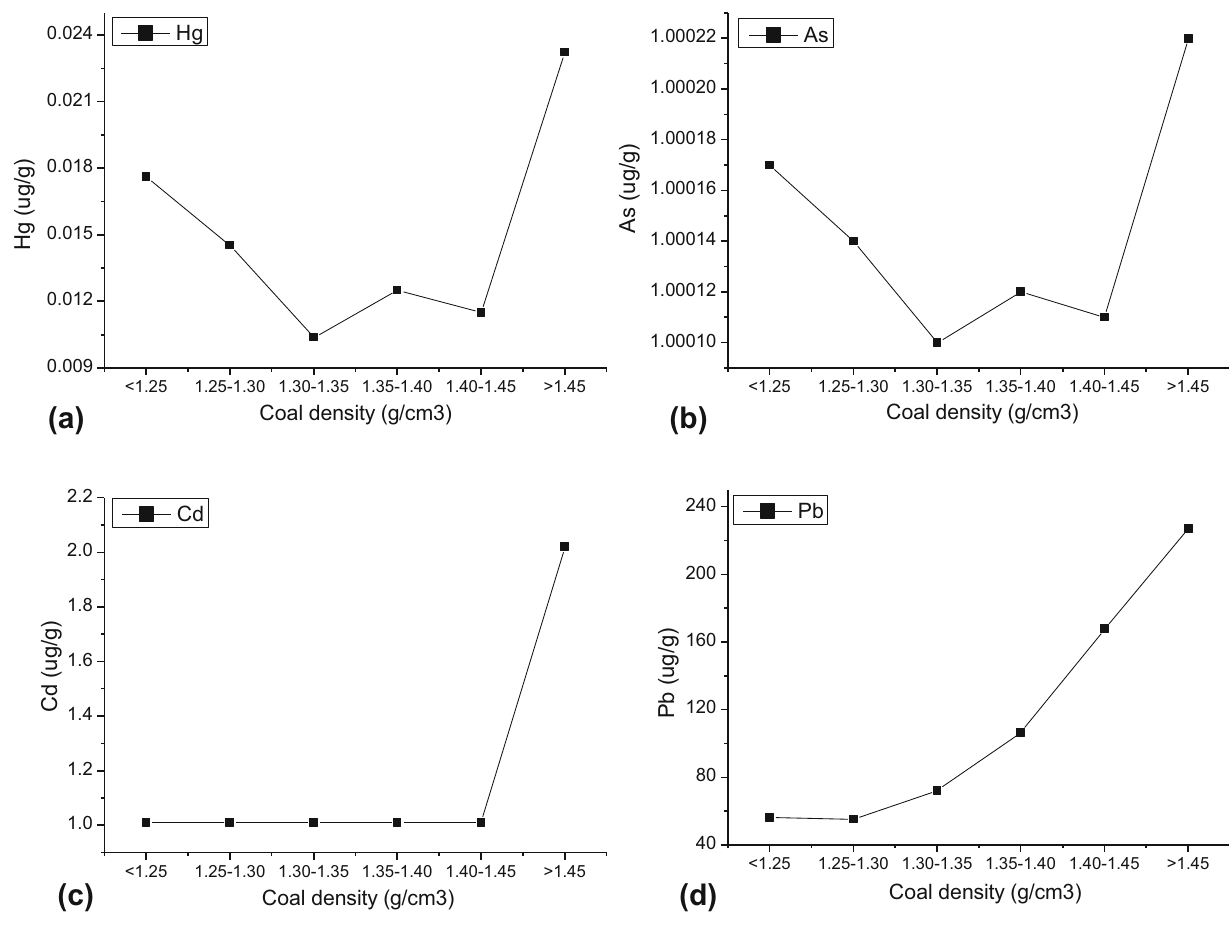
Fig. 3 Heavy metals of coal in different densities by sink-and-float test, a Hg, b Ar, c Cd, d